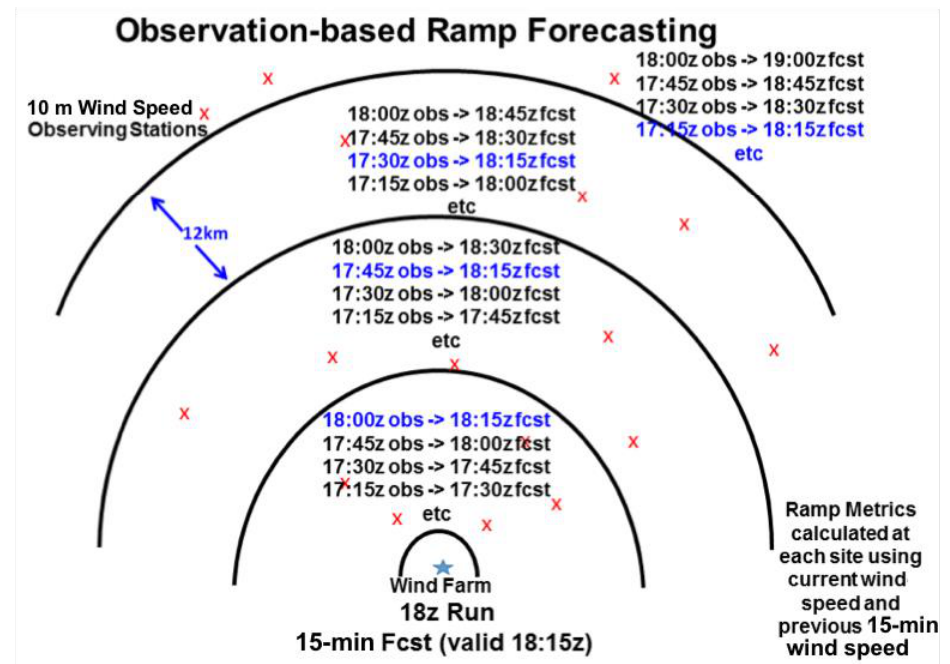
Figure 8. Schematic of the observations-based expert system for short-term forecasting. Available wind speed observations at 10 m in concentric circles around a wind farm are used to calculate the wind ramp metric, which is then used to compute changes in power production.